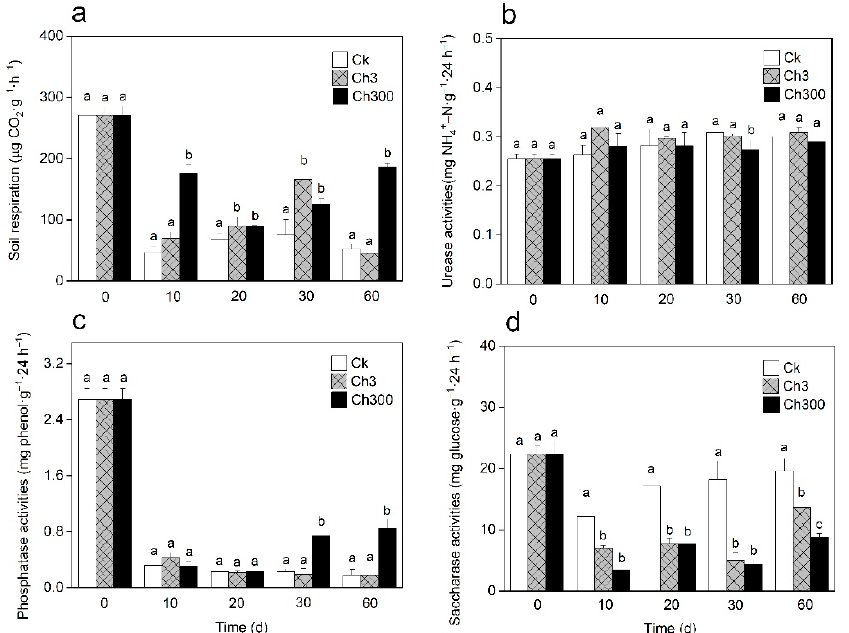
Figure 2. Changes in soil respiration and enzymatic activities of different treatments: ( a ) soil respiration; ( b ) urease activity; ( c ) phosphatase activity; ( d ) saccharase activity. Ck represents soil without chlorothalonil. Ch 3 represents soil with 3.0 mg·kg − 1 chlorothalonil. Ch 300 represents soil with 300 mg·kg − 1 chlorothalonil. All values represent mean ± standard deviation of triplicate samples.